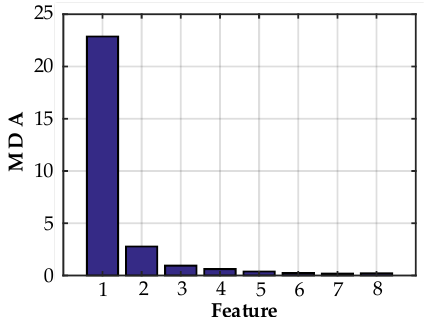
Figure 6. Calculated MDA values with respect to the historical wind speed. Note: Features 1–8 represent the historical wind speeds of the periods from 4–11 × 15 min before the current period, respectively.